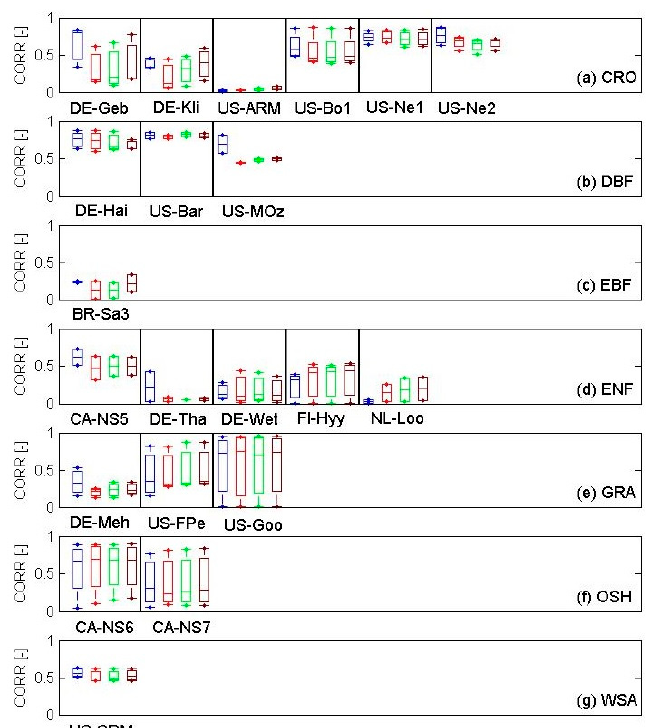
Figure 3. Analysis of relationship (CORR: Coe ffi cient of determination) between NDVI is and NDVI MD at di ff erent spatial resolutions (0.5 × 0.5 km: blue; 1.5 × 1.5 km: red; 2.5 × 2.5 km: green; and 3.5 × 3.5 km: brown) in di ff erent biomes ( a ) CRO: Cropland; ( b ) DBF: Deciduous broadleaf forest; ( c ) EBF: Evergreen broadleaf forest; ( d ) ENF: Evergreen needle leaf forest; ( e ) GRA: Grassland; ( f ) OSH: Open shrubland; and ( g ) WSA: Woody savanna).